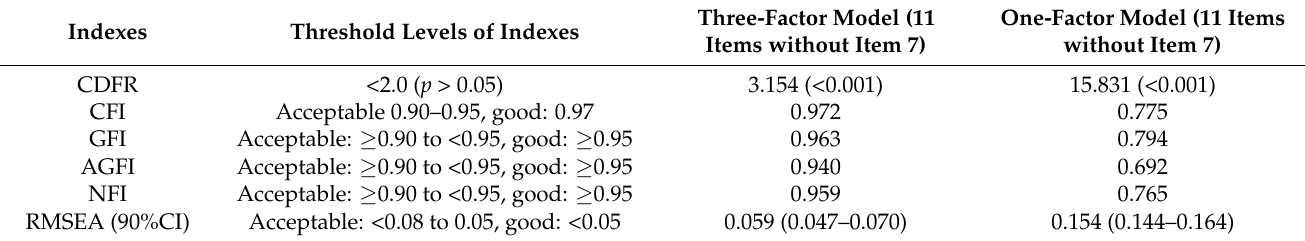
Figure 2. The CFA measurement model for the Polish version of the Short Food Literacy Questionnaire. Table 6. The results of fitting the three-factor